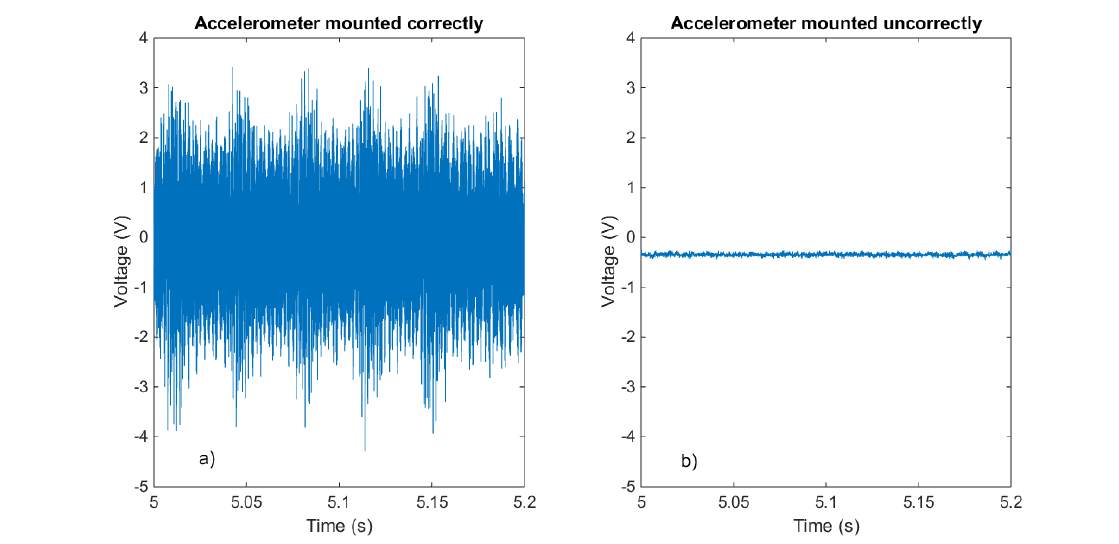
Figure 2. Comparison of the vibration signal acquired by an accelerometer mounted correctly ( a ) and an accelerometer mounted incorrectly ( b